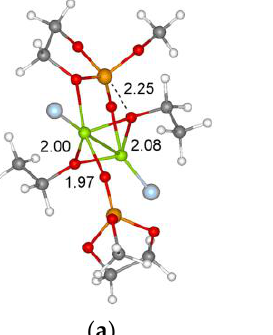
( b ) Figure 2. ( a ) Cooperative effect of di-Mg core in transition state DTS-12 ; ( b ) Geometries of the highly 235 distorted transition state DTS-12i and intermediate DI-2i with a highly weakened exocyclic P – O 236 bond (DBP fragments are omitted for clarity, DBP oxygen atoms are marked in blue). 237 238